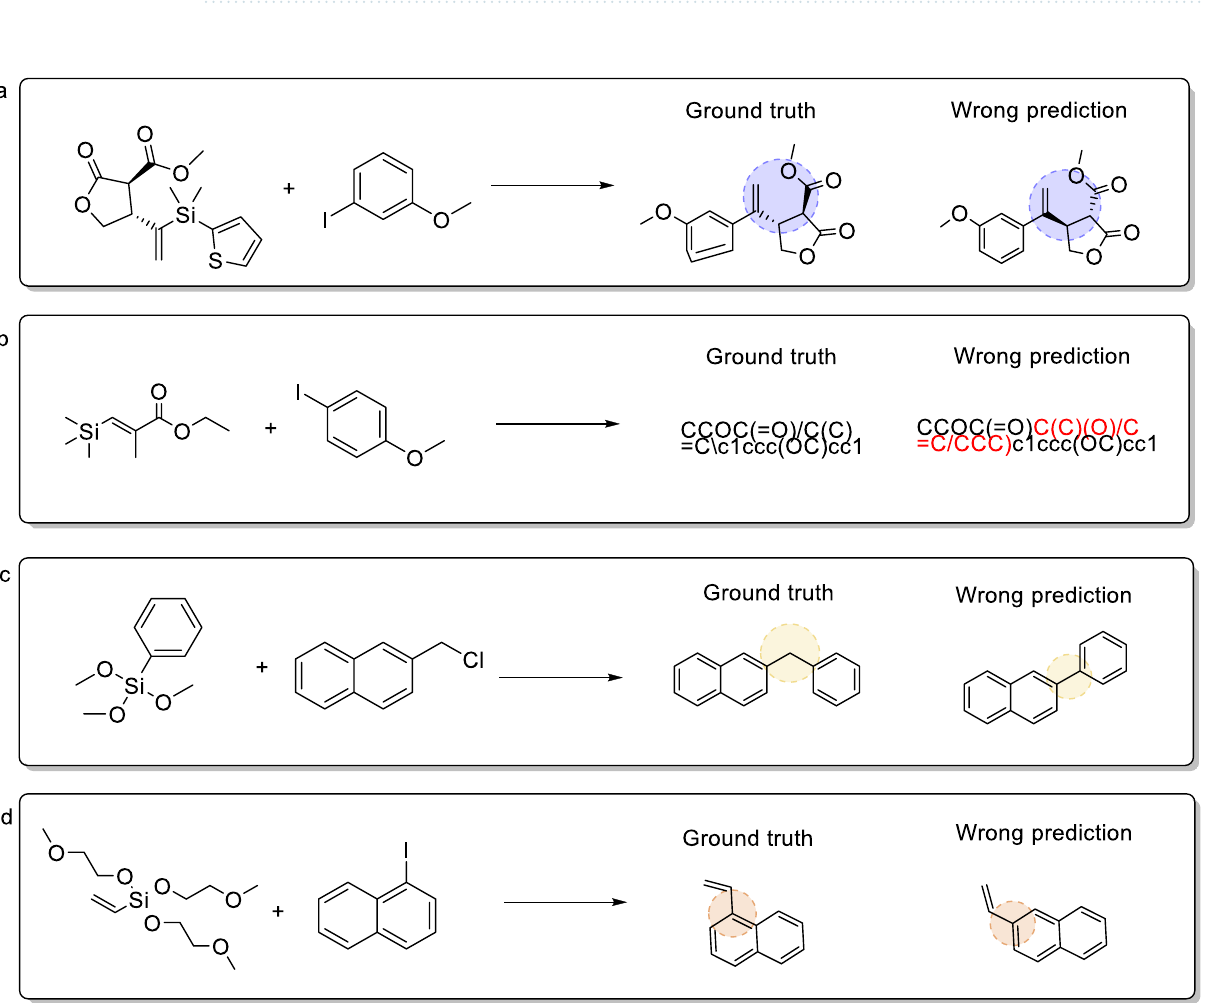
Table 6. The number of error types in reaction prediction for five coupling reactions.